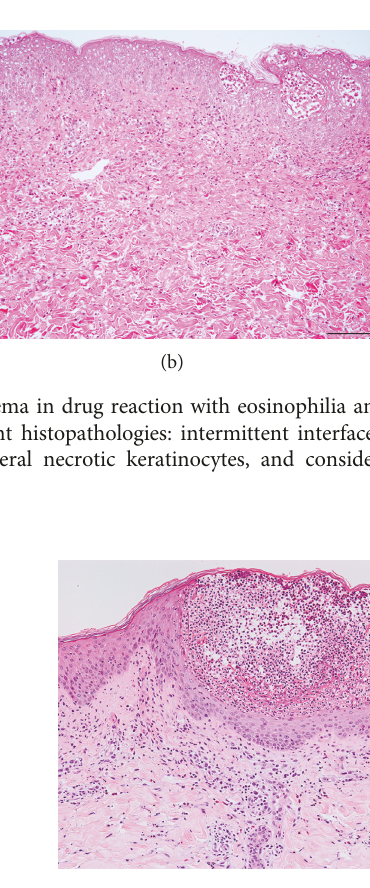
Figure 3: An HE section of acute generalized exanthematous pustulosis shows spongiform super fi cial intraepidermal pustules and polymorphous perivascular in fi ltrates containing mostly neutrophils. Bar=100 μ